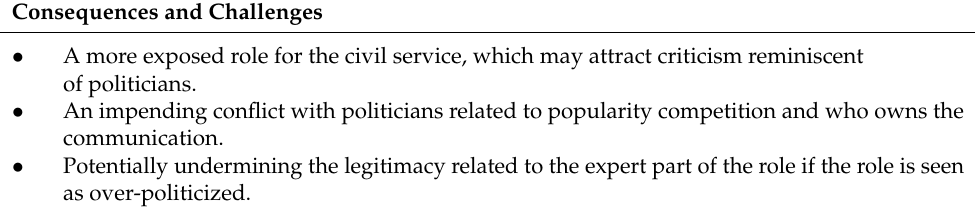
Table 4. Challenges caused by the hyper-mediatized role of the civil